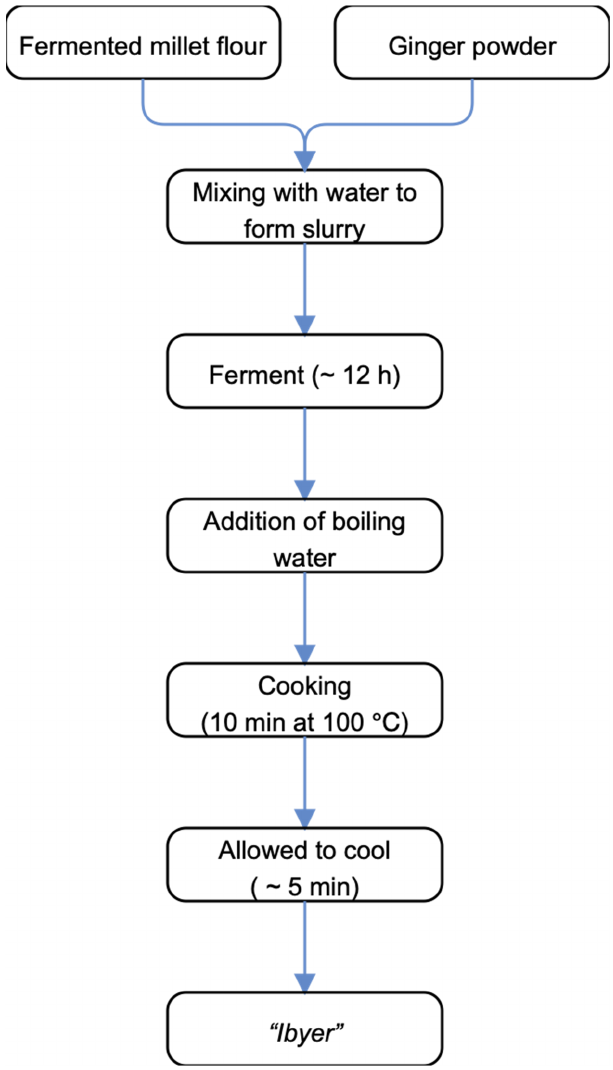
Figure 4. The schematic diagram depicting the major steps fermented millet flour enhanced with ginger powder makes the “ Ibyer ” beverage (Adapted from Kure and Wyasu [31]). Table 1. Blend formulation of fermented millet flour enhanced with ginger powder for “ibyer” production. Sample Code